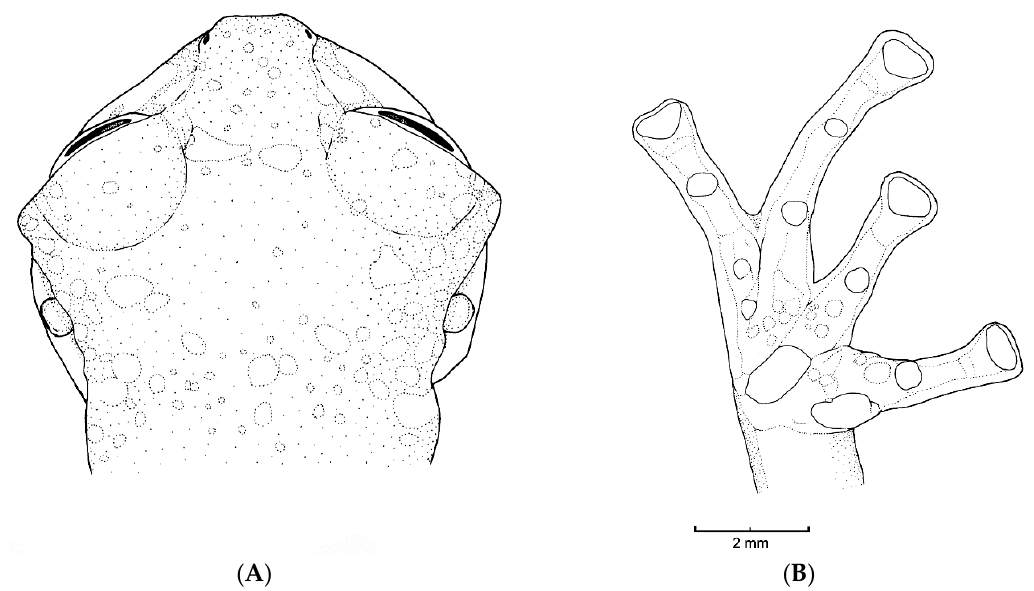
Figure 168. Nymphargus mariae , holotype, female, KU 174713. ( A ) Head in lateral view. ( B ) Hand in ventral view. Illustrations by Juan M. Guayasamin.